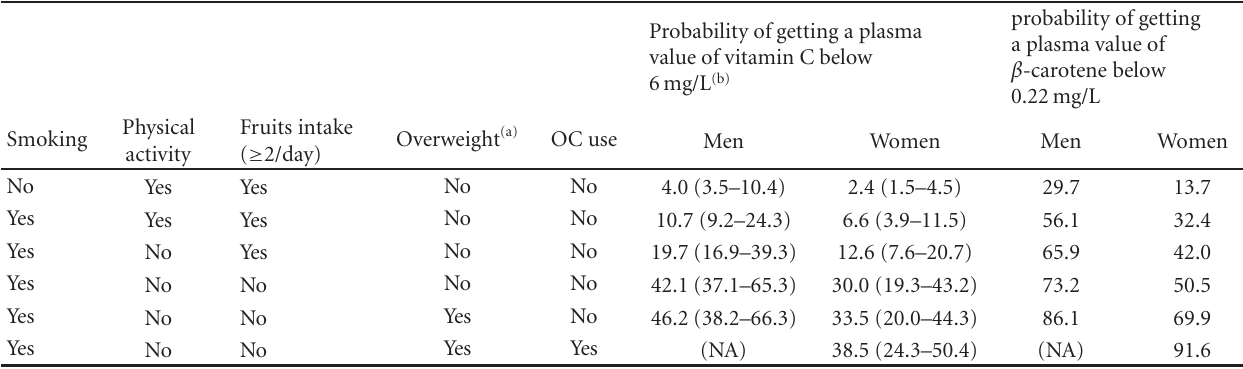
Table 4: Probability of developing vitamin C deficiency and β -carotene deficiency according various risk factors combinations (from no risk factor present to all risk factors present) in men and women. For vitamin C, results in parentheses indicate probability for employed and unemployed subjects.